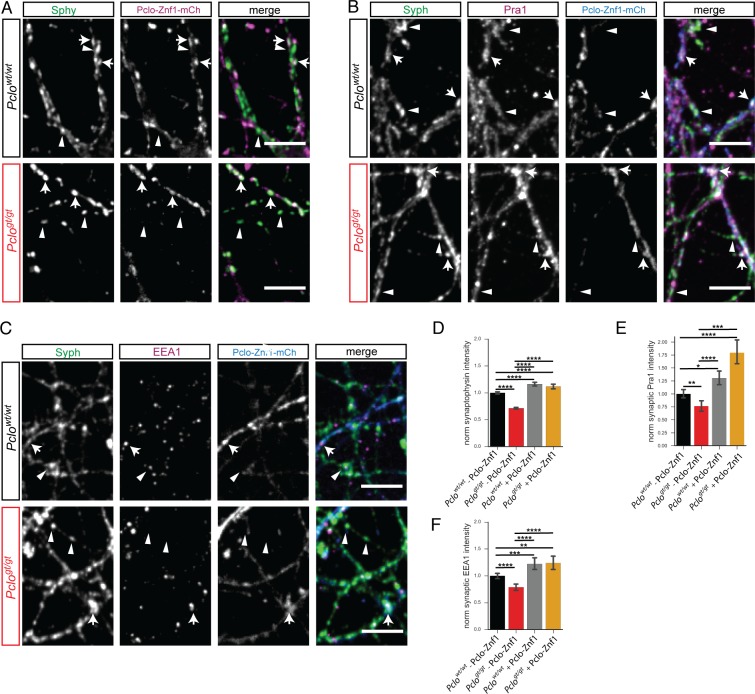
Expressing Pclo-Znf1-mCh rescues Pra1, EEA1 and Synaptophysin levels in Pclogt/gt neurons.(A–C) Images of Pclowt/wt and Pclogt/gt neurons either expressing or not expressing Pclo-Znf1-mCh (arrows vs arrowheads) that were fixed and stained for Synaptophysin (A) and Pra1 (B) or EEA1 (C). (D) Quantification of (A). Pclo-Znf1-mCh slightly increases Synaptophysin levels in Pclowt/wt neurons (Pclowt/wt = 1 ± 0.01, n = 1497 synapses; Pclowt/wt + Pclo-Znf1-mCh = 1.16 ± 0.02, n = 710; four independent experiments). In Pclogt/gt boutons expressing Pclo-Znf1-mCh (arrows), Synaptophysin levels are increased compared to non-expressing boutons (arrowheads). (Pclogt/gt = 0.71 ± 0.01, n = 1203; Pclogt/gt + Pclo-Znf1-mCh = 1.12 ± 0.02, n = 590; four independent experiments). (E) Quantification of (B). Pclo-Znf1-mCh increases synaptic Pra1 levels in Pclowt/wt neurons (Pclowt/wt = 1 ± 0.04, n = 1136 synapses; Pclowt/wt + Pclo-Znf1-mCh = 1.31 ± 0.07, n = 543; 3–5 independent experiments). Pclo-Znf1-mCh rescues and further increases synaptic Pra1 levels in Pclogt/gt neurons (Pclogt/gt = 0.76 ± 0.05, n = 1064; Pclogt/gt + Pclo-Znf1-mCh = 1.80 ± 0.12, n = 445; 3–5 independent experiments). (F) Quantification of (C). Pclo-Znf1-mCh expression increases synaptic EEA1 levels in Pclowt/wt neurons (Pclowt/wt = 1 ± 0.03, n = 1652 synapses; Pclowt/wt + Pclo-Znf1-mCh = 1.22 ± 0.05, n = 709; 3–5 independent experiments). Pclo-Znf1-mCh rescues and further increases synaptic EEA1 levels in Pclogt/gt neurons (Pclogt/gt = 0.79 ± 0.03, n = 1633; Pclogt/gt + Pclo-Znf1-mCh = 1.24 ± 0.06, n = 464; 3–5 independent experiments). Scale bars represent 10 μm. Error bars in bar graph represent 95% confidence intervals. Numbers given represent mean ± SEM, ANOVA with Tukey multi comparison test. * denotes p<0.05, ** denotes p<0.01, *** denotes p<0.001 and **** denotes p<0.0001.10.7554/eLife.46629.029Figure 10—source data 1.This spreadsheet contains the normalized values used to generate the bar plots shown in Figure 10D,E and F.